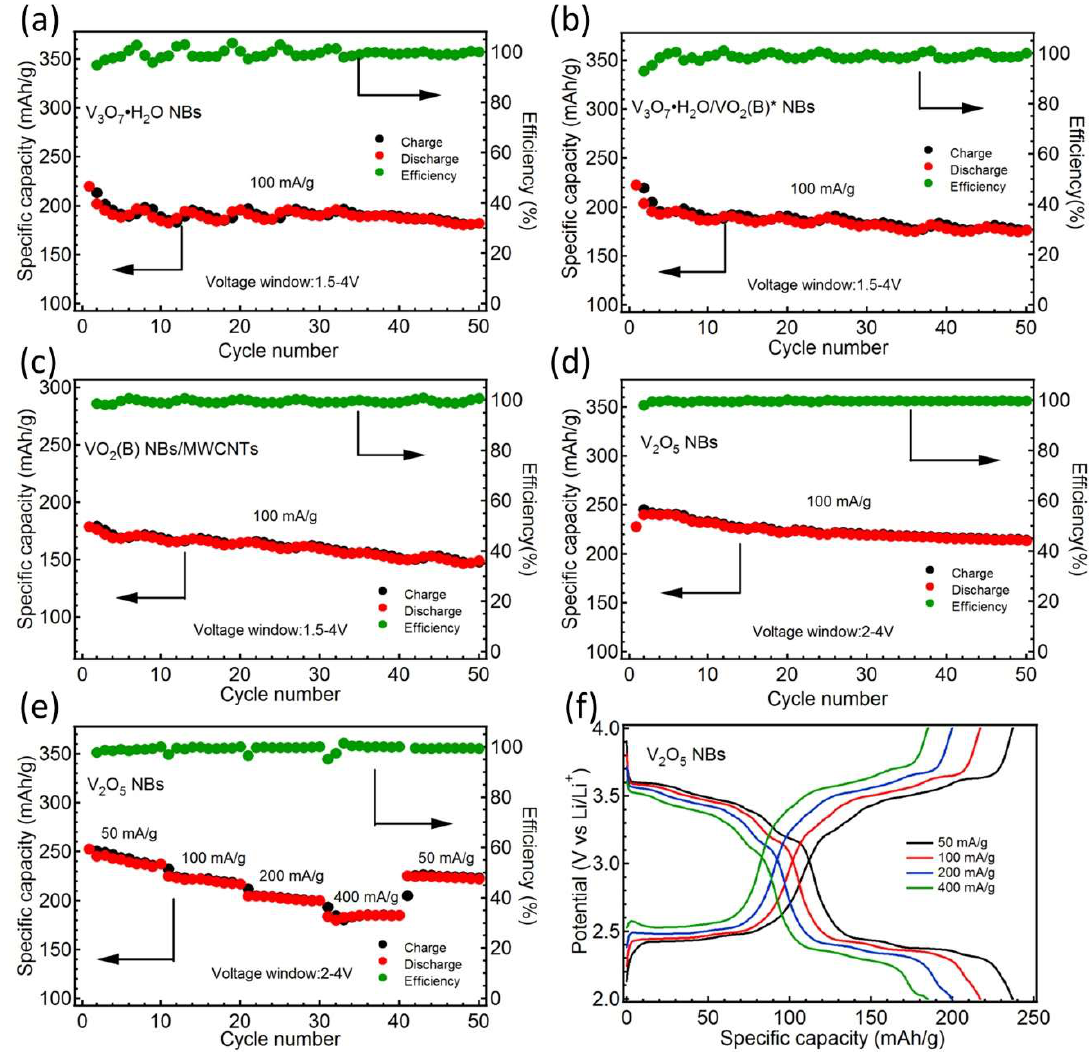
Figure 8. Cycling performances and coulombic efficiencies of V 3 O 7 ·H 2 O NBs ( a ), V 3 O 7 ·H 2 O/VO 2 (B)* NBs ( b ), VO 2 (B) NBs / MWCNTs ( c ) and V 2 O 5 NBs ( d ) at 100 mA g − 1 ; rate capability ( e ) and typical